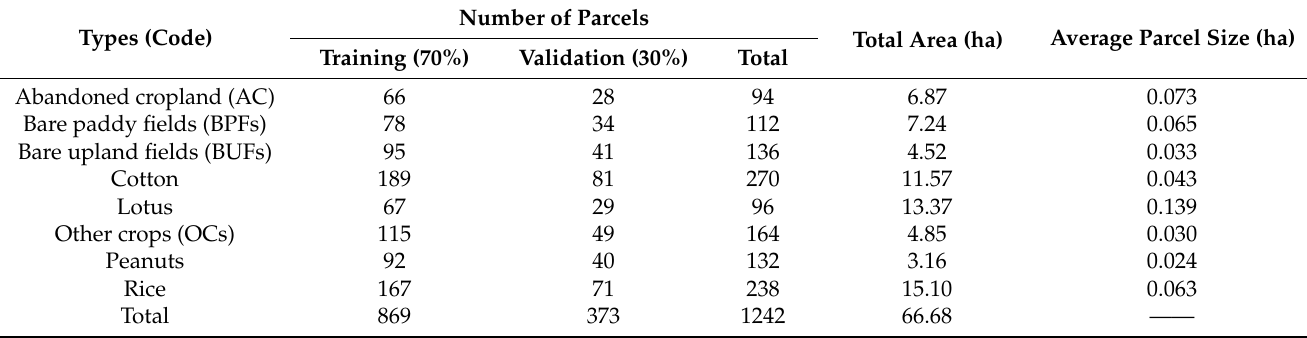
Table 1. Overview of the ground-truth